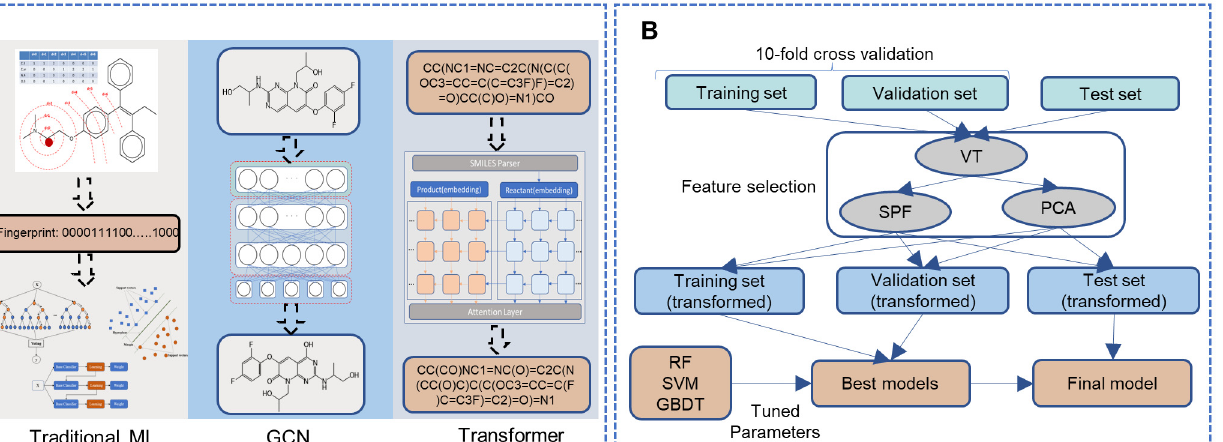
Figure 1. The framework of this study. ( A ) The overview of our work. ( B ) The details of the finger- print-based method. ( C ) The workflow of the WLN model to obtain the atom environment features. ( D ) The whole workflow of the sequence-based model in this study. (ML: machine learning, GCN: graph convolutional network, VT: variance threshold, SPF: select percentile of feature, PCA: princi- pal component analysis, RF: random forest, SVM: support vector machines, GBDT: gradient boosted decision trees.) 2. Materials and Methods We employed three ligand-based machine-learning methods to build SOM predic- tion models for hAOX. They are fingerprint-based, graph-based, and sequence-based methods, respectively. The fingerprint-based method was trained by the Scikit-learn py- thon package (https://scikit-learn.org/0.24/ (accessed on 15 December 2022)) [21]. The graph-based method was trained